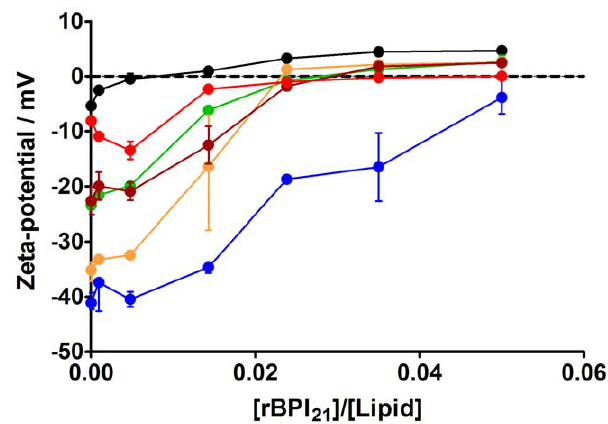
Figure 6. Fusion or hemifusion of membrane model systems promoted by rBPI 21 . LUV labeled with 0.6% mol of RhB-PE and NBD- PE were mixed with unlabeled liposomes to a final proportion of 1:4 and the energy transfer assay was evaluated in the presence of rBPI 21 after 10 min of incubation. Bars represent the range from three independent experiments. POPC (black circles); POPG (blue circles); POPC:POPG 55:45 (orange circles); POPC:POPG 80:20 (green circles); POPC:LPS 80:20 (red circles); POPC:POPG:LPS 60:20:20 (brown circles). The differences in (hemi)fusion percentage for rBPI 21 9 m M were statistically significant between all data pairs, except POPC/POPC:LPS (80:20). doi:10.1371/journal.pone.0008385.g006 phase, due to the high density of the positive amino acids in rBPI 21 , exposing the hydrophobic region of the lipid for the interaction with the peptide [38,39]. Despite the lower aggregation state of the POPC:LPS in the presence of rBPI 21 , the peptide is